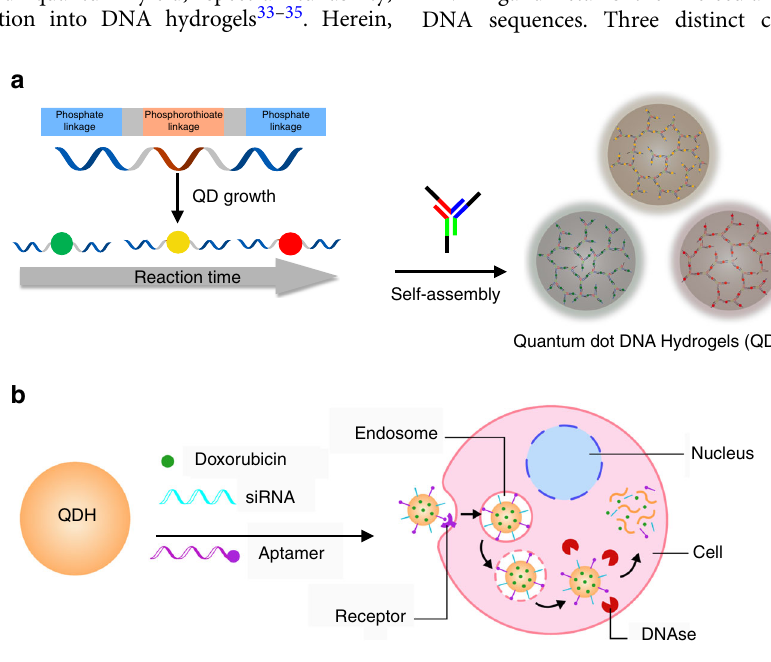
Fig. 1 Schematic illustrations of synthesis of self-assembled QDHs, modi fi cation with therapeutic or targeting agents, and cellular uptake mechanism. a Synthesis of DNA-functionalized QDs and the subsequent formation of QDH through hybridization with DNA three-way junction nanostructures. b Modi fi cations of QDH for cell-speci fi c targeting with an aptamer and siRNA/drug delivery. Doxorubicin and siRNA are released upon cellular uptake via